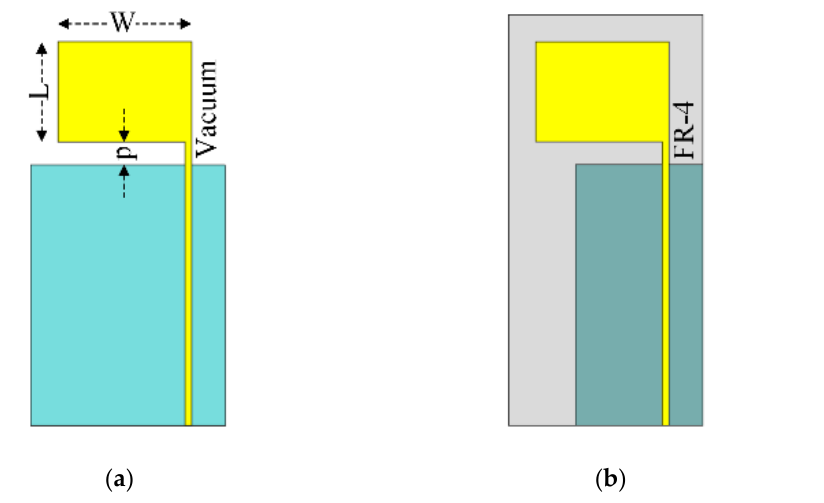
Figure 2. Inverted L-shaped planar monopole antenna on the partial ground plane: ( a ) in vacuum, ( b ) with FR-4 substrate.